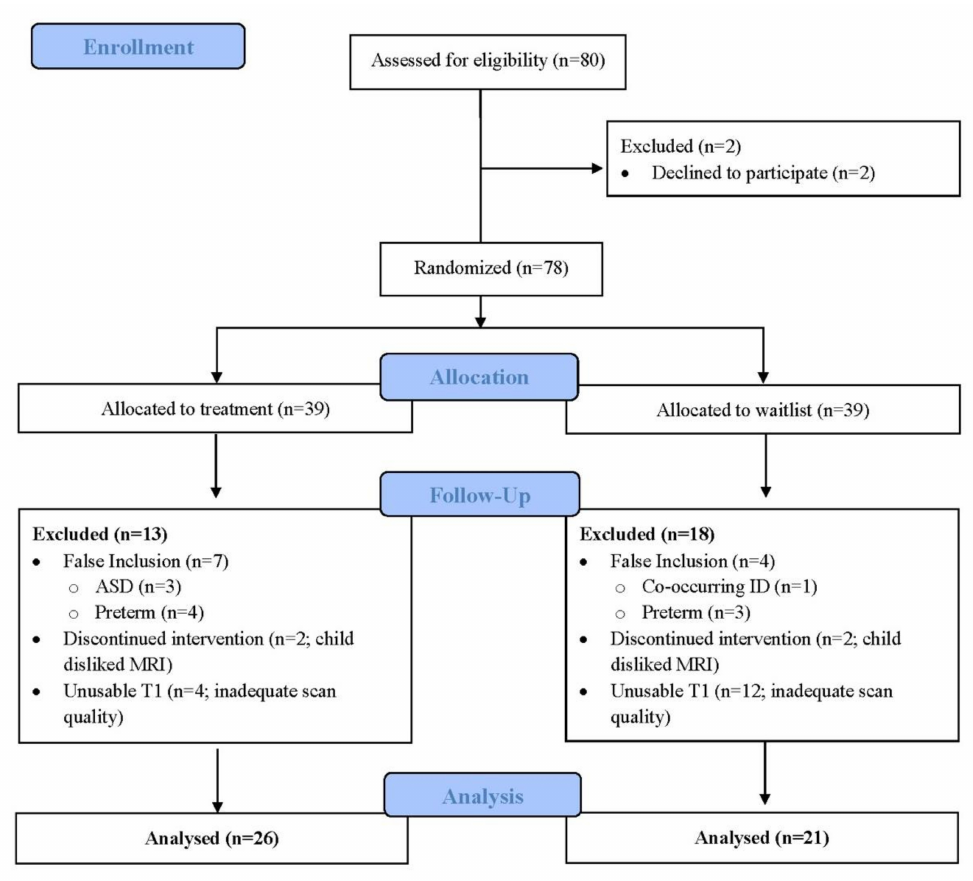
Figure 1. Participant flow